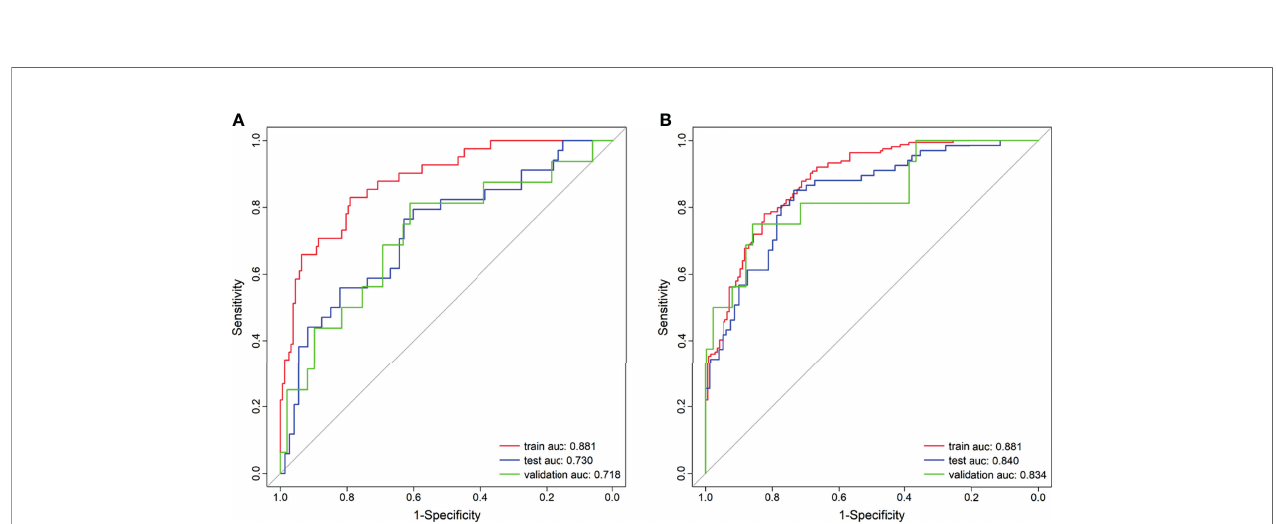
FIGURE 3 | Receiver operating characteristic (ROC) curves of the radiomics signature. (A) Without synthetic minority oversampling technique (SMOTE) method. (B) With SMOTE method.